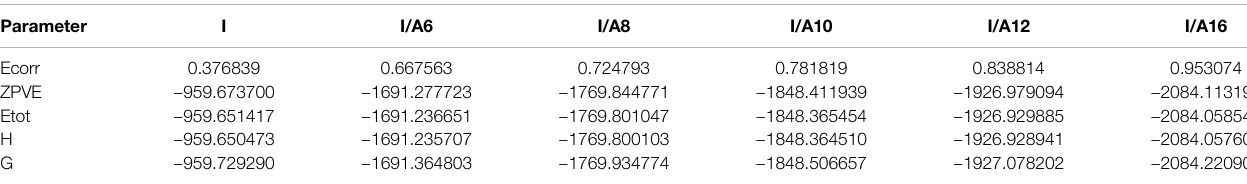
TABLE 3 | Thermal parameters (Hartree/Particle) of the H-bonded complexes I/An.